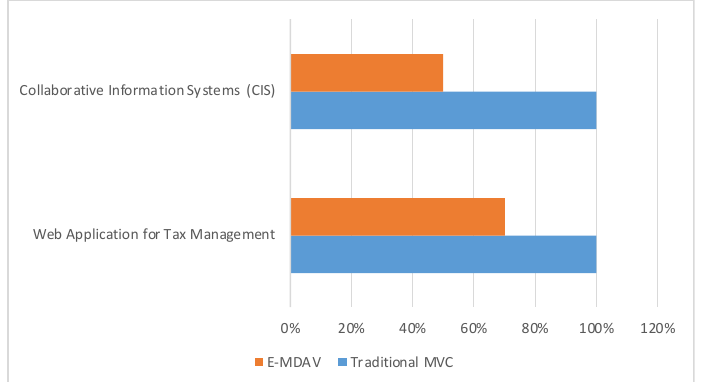
Figure 14. MVC and E-MDAV project effort